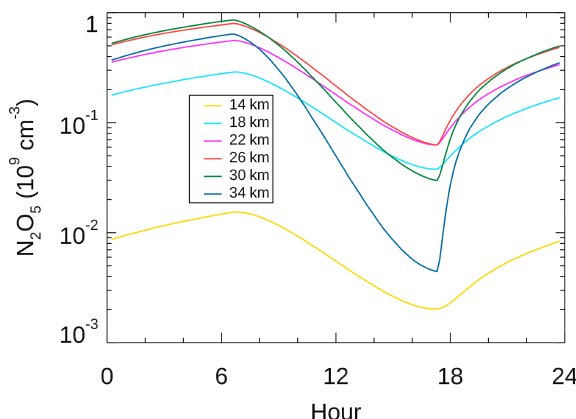
Figure 6. Same as Fig. 5b except for N 2 O 5 .